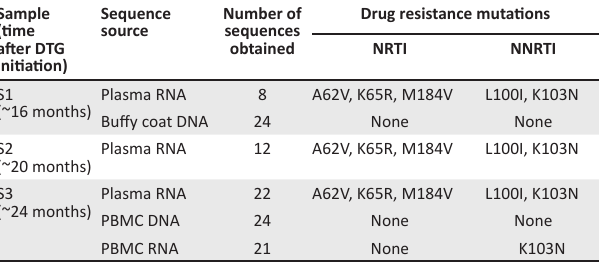
TABLE 2: Patient p6-protease-reverse transcriptase nucleotide sequences obtained from various sources for each sample with drug resistance mutations detected.